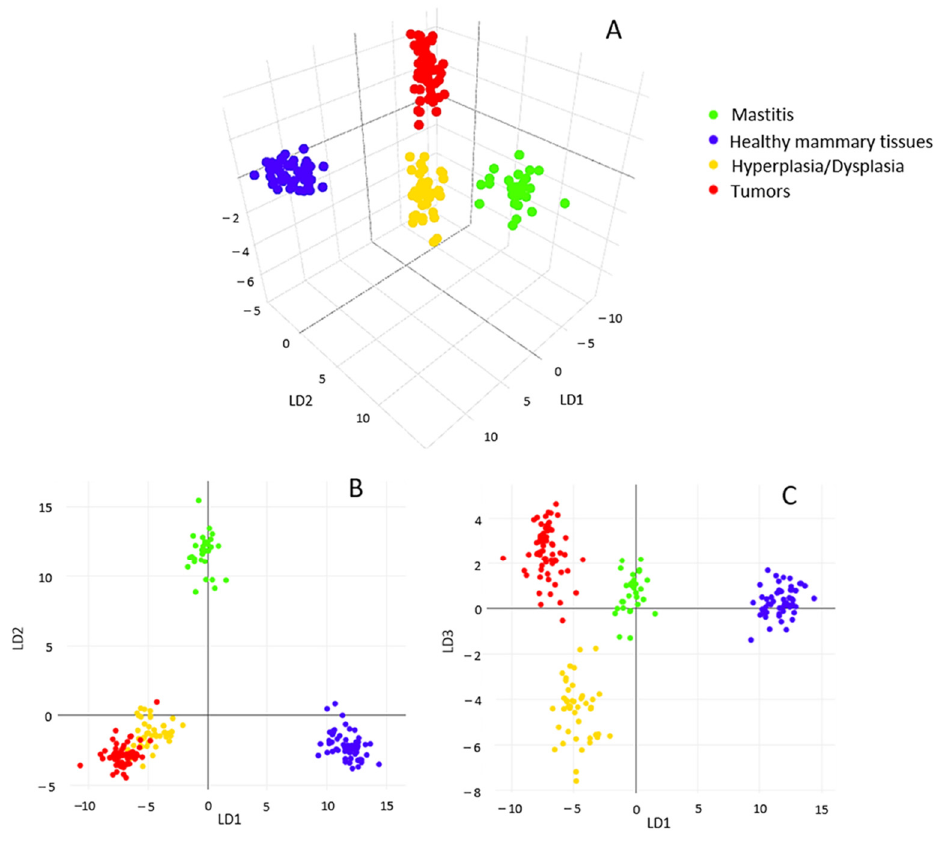
Figure 2. Tridimensional visualization of PCA/LDA statistical model ( A ); bidimensional score lots along first three main linear discriminants (LD): LD1/LD2 ( B ) and LD1/LD3 ( C ).